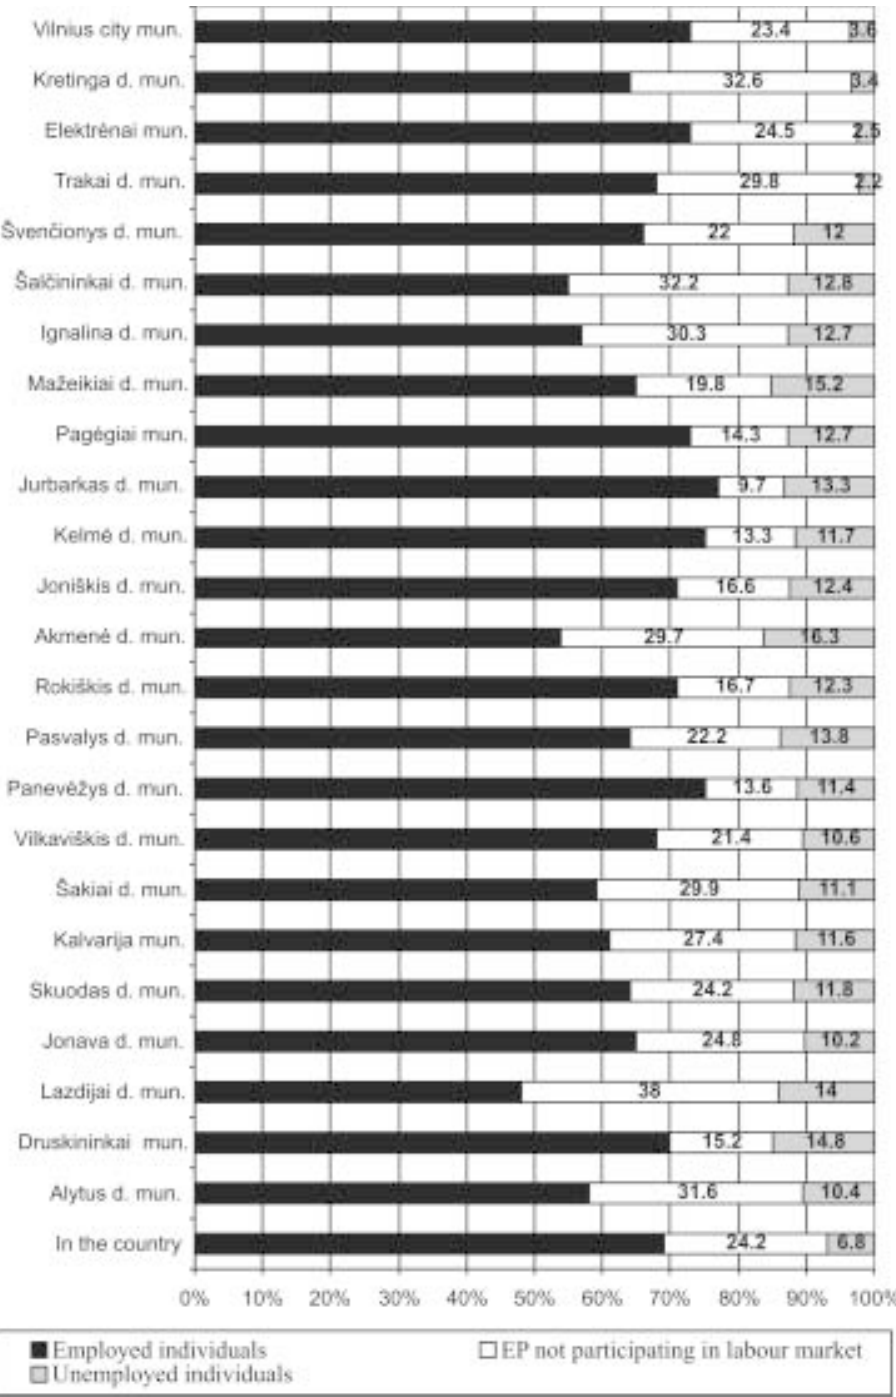
Fig 1. Structure of employable population (EP) in depressive regions of Lithuania in 2004